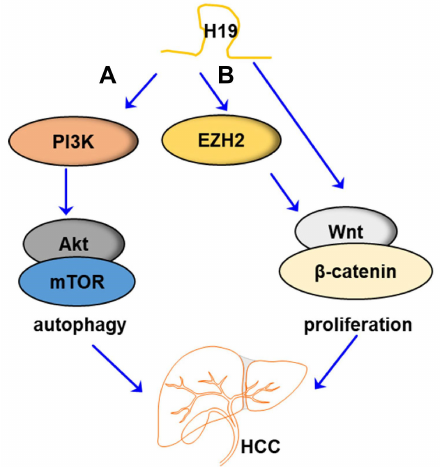
Figure 3. The potential targets of LncRNA H19 in HCC. ( A ) H19 induced the expression of PI3K, which further activated the Akt/mTOR signaling pathway, thus modulating autophagy and even- tually promoting the development of HCC. ( B ) H19 induced the expression of EZH2, which further activated the Wnt/ β -catenin signaling pathway, thus regulating proliferation and eventually pro- moting the development of HCC.